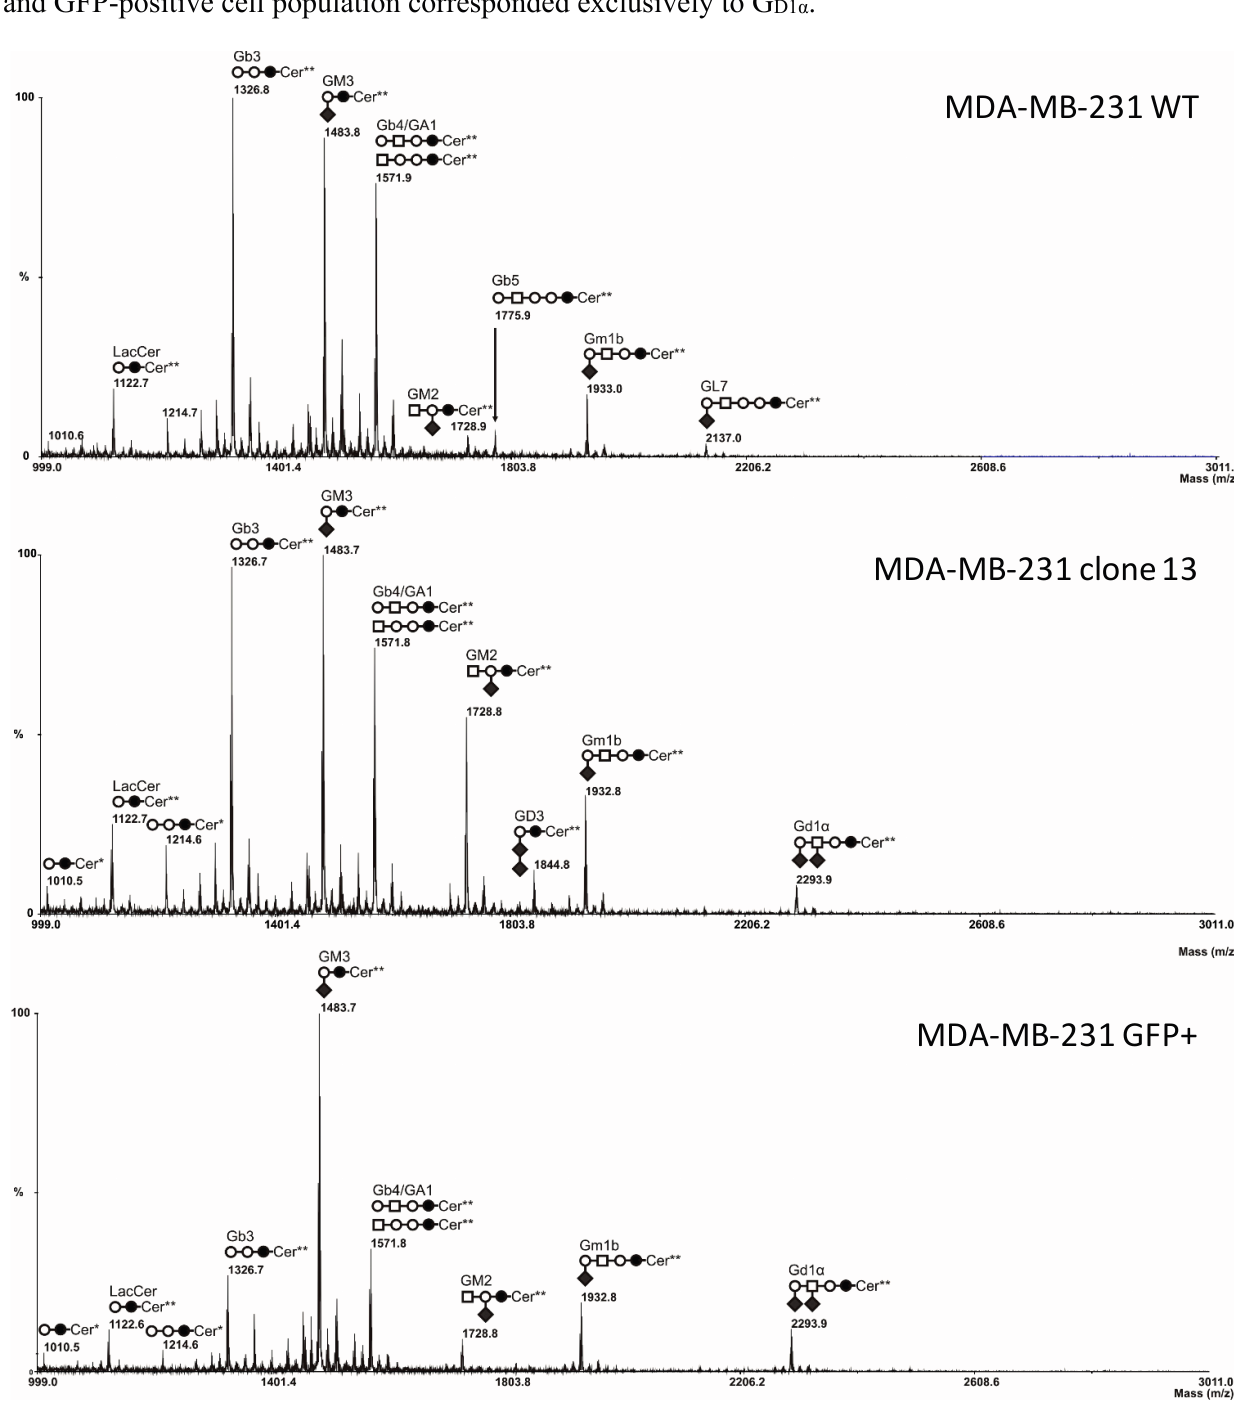
Figure 4. Comparison of MS profiles of permethylated glycosphingolipids purified from MDA-MB-231 wt, clone #13 and GFP+ ST6GalNAc V transfected cells. GSL are present as d18:1/C16:0 (Cer*) and d18:1/C24:0 (Cer**) isomers. , Gal; , Glc; , GalNAc; ,